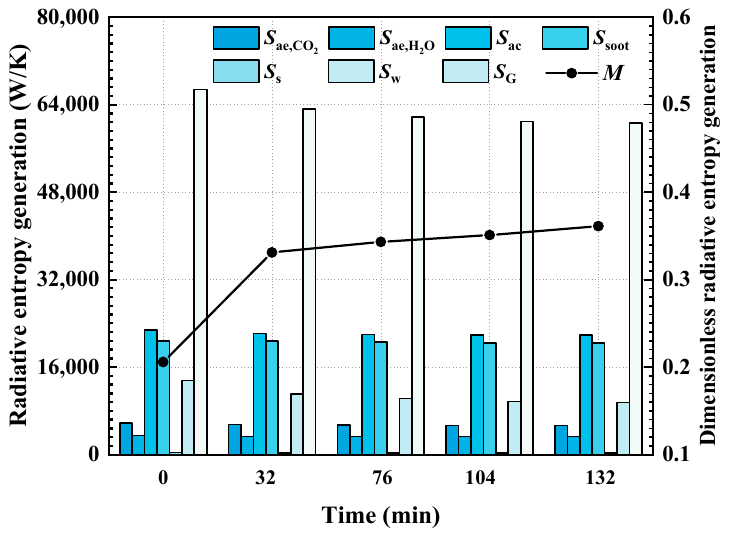
Figure 7. The total entropy generation rate and entropy generation rate due to various reasons during the combustion process of bituminous coal (Illinois #6).